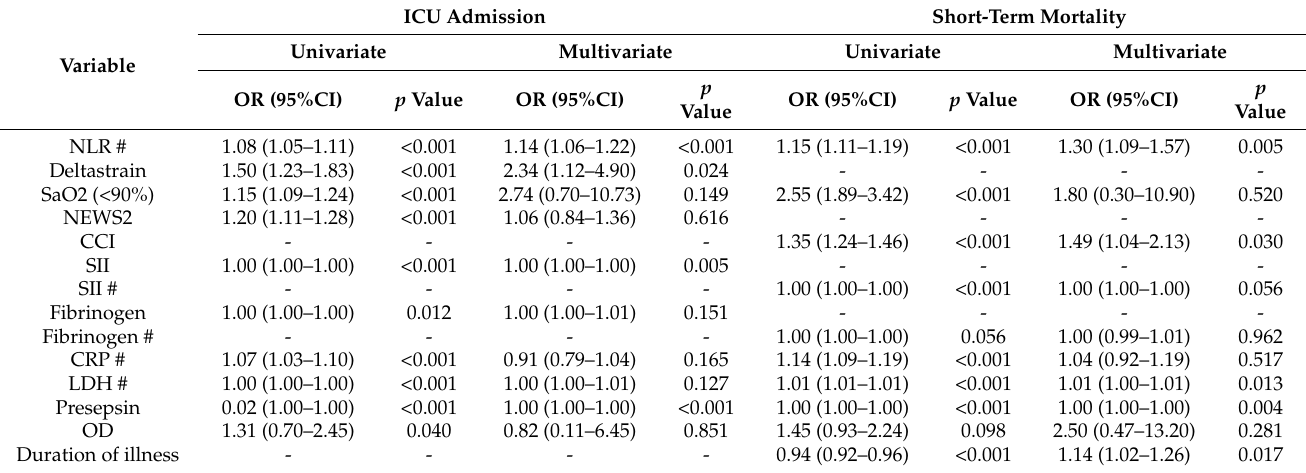
Figure 2. Boxplots displaying NLR values according to the main outcomes: ( a ) follow-up NLR was significantly higher in patients admitted to ICU; ( b ) follow-up NLR was significantly higher in non- survivors 30 days post-discharge; ° represent outliers; * represent extreme values.